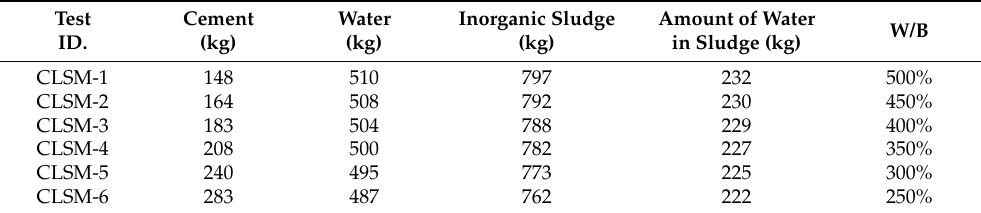
Table 4. Mix proportion of CLSM using stone sludge (kg/m 3